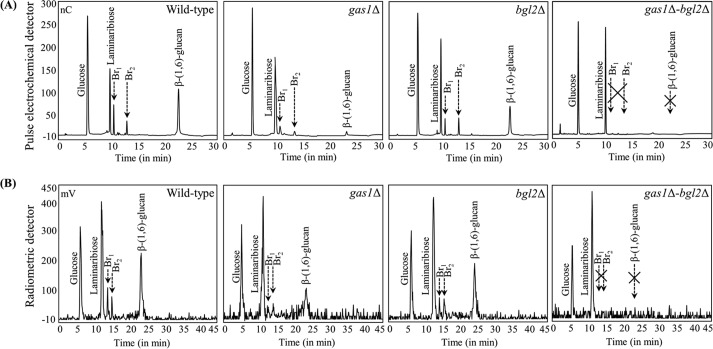
β-(1,3)-Glucan branching was decreased in the Scgas1Δ and Scbgl2Δ mutants, while the Scgas1Δ bgl2Δ mutant was devoid of branching on β-(1,3)-glucan. (A and B) Dionex profiles of the LamA-digested cell wall AI fractions from the wild-type strain, single gas1Δ mutant, single bgl2Δ mutant, and double gas1Δ bgl2Δ mutant (A) and AI fractions from the corresponding permeabilized cells incubated with UDP-(14C)glucose (B) (gradient run II for panel A and gradient run I for panel B).